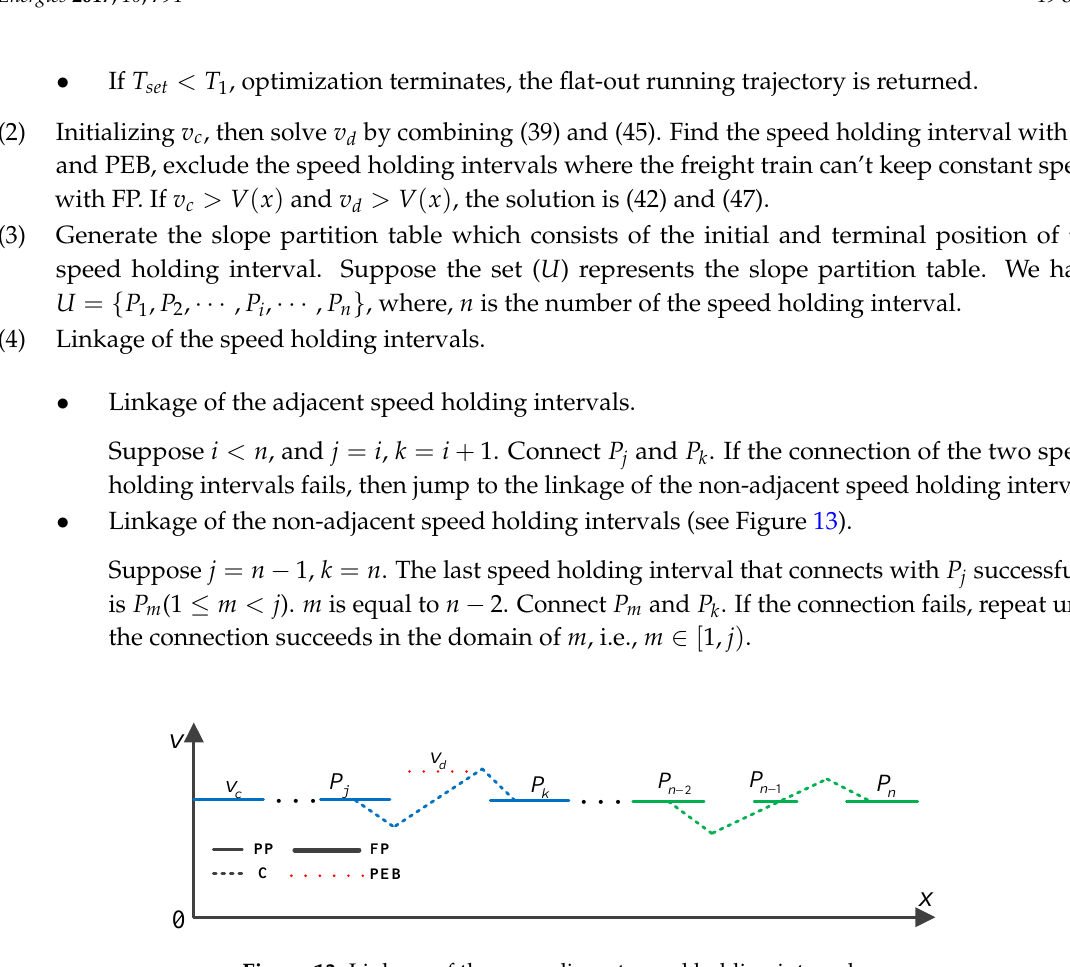
Figure 13. Linkage of the non-adjacent speed holding interval.